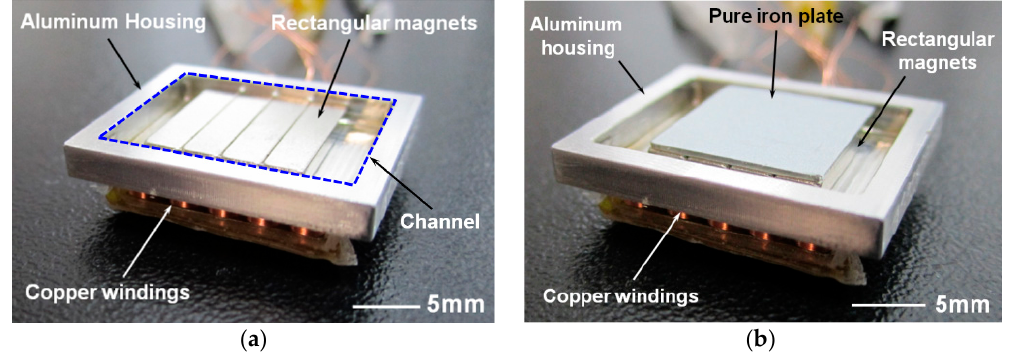
Figure 5. Proof-of-concept energy harvester after assembly: ( a ) pole piece covering the magnets and acrylic plate on top has been removed for visibility of the magnet array; ( b ) with pole piece covering the magnet array.